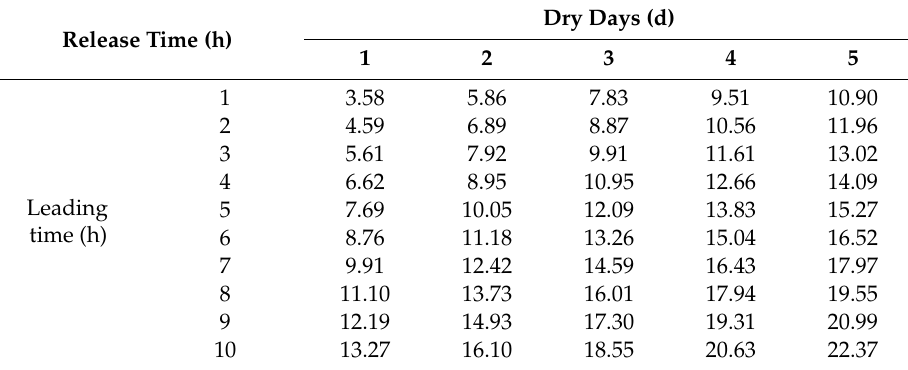
Table 5. Release times in di ff erent scenarios.